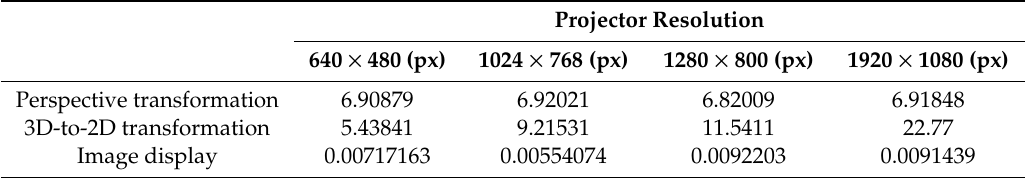
Table 2. Results of data processing times for dynamic video mapping of the box—Variant